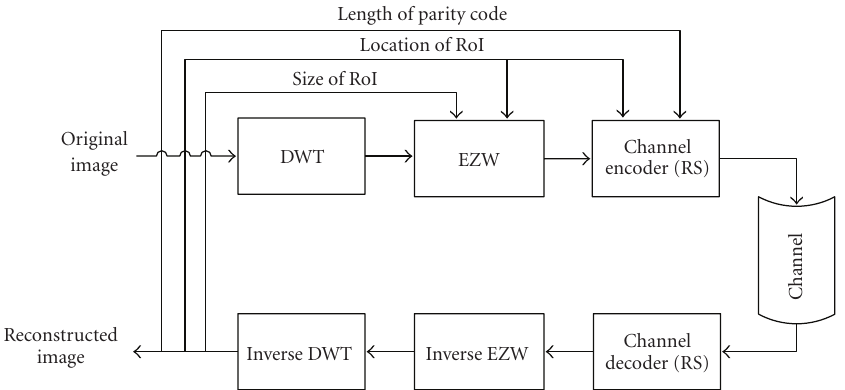
Figure 1: The overall system block diagram.